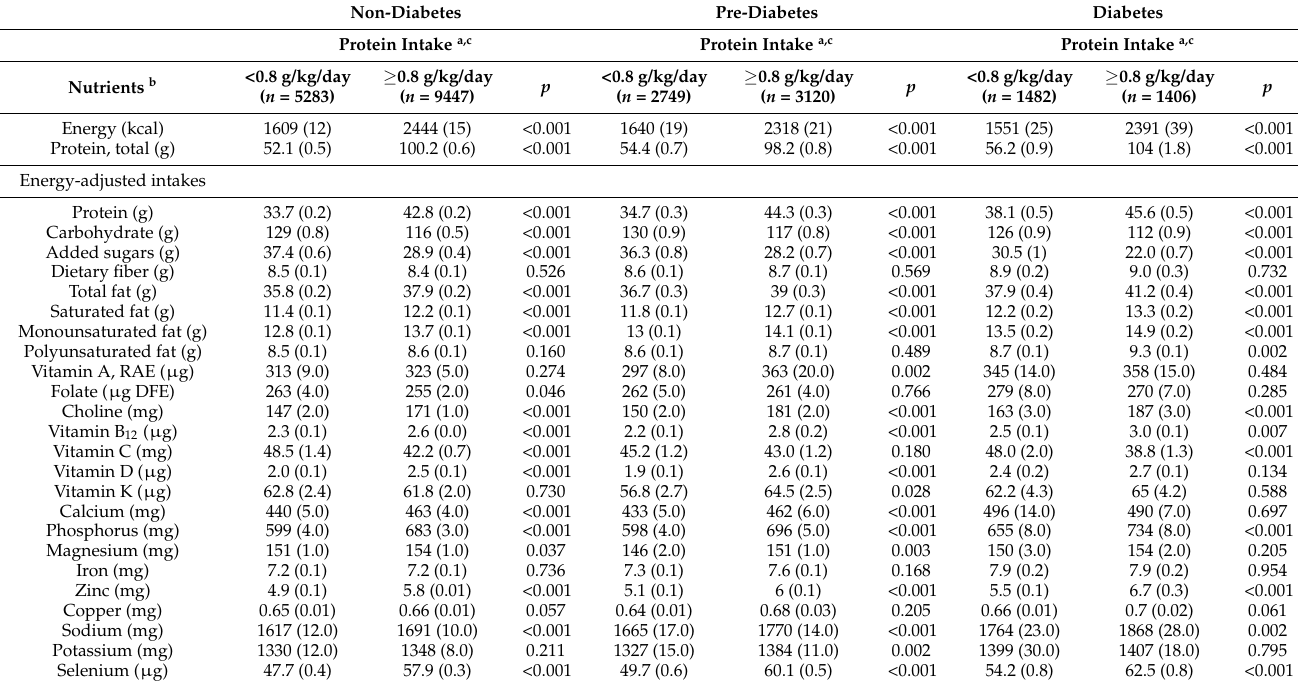
Table 2. Differences in energy and energy-adjusted nutrient intakes across diabetes status for those who were below or met the protein intake recommendation from the 2005–2016 National Health and Nutrition Examination Survey (NHANES) a,c .